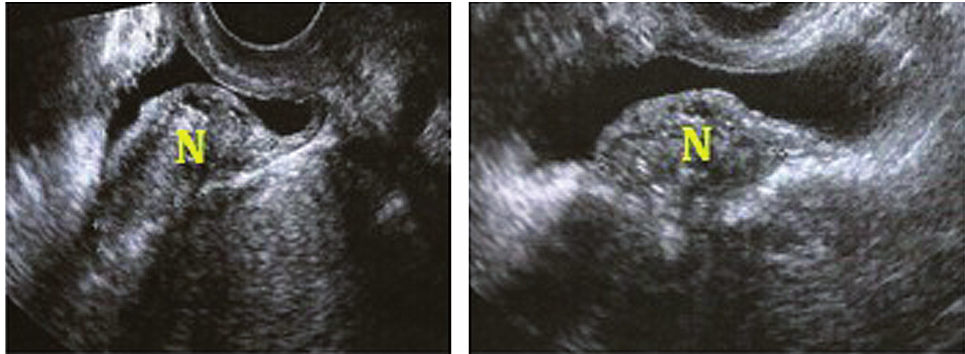
Figure 1C - MRI of the pelvis depicting hypo-signal on T2 (lesion is highlighted).